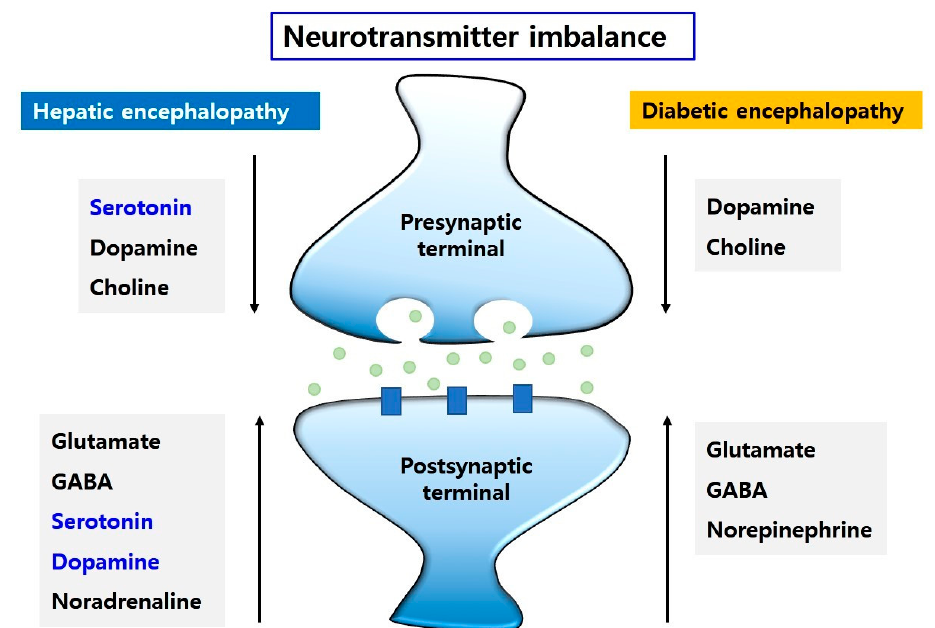
Figure 2. The neurotransmitter imbalance in HE and DE. The changes in neurotransmitters, such as glutamate, GABA, serotonin, dopamine, and noradrenaline, may lead to motor dysfunction, learning and memory dysfunction, and emotional disturbance. The levels of dopamine and choline are decreased and the levels of glutamate, GABA, and norepinephrine are increased in HE and DE. However, Dopamine and serotonin levels are elevated in HE. Conversely, serotonin level is reduced in HE.